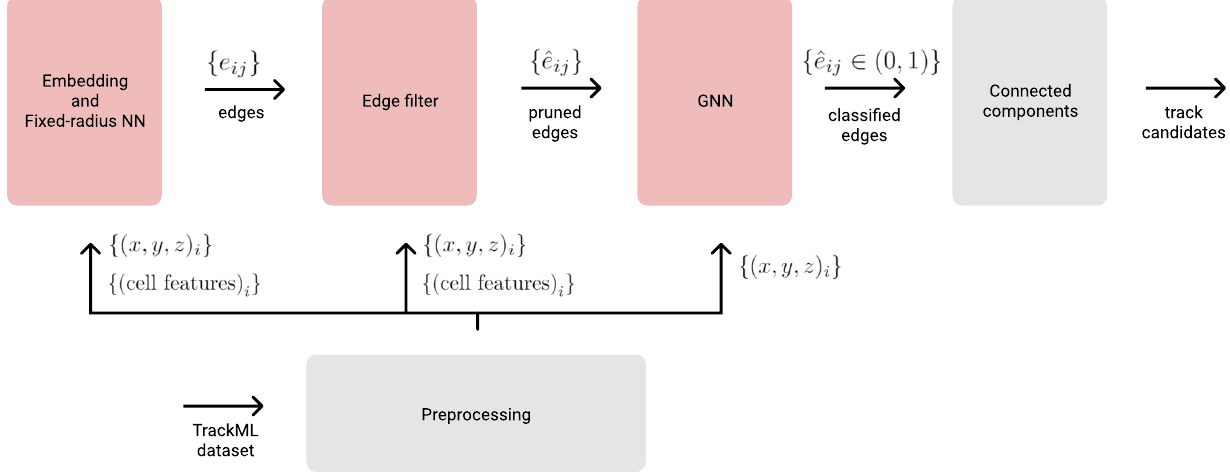
Fig. 4 Stages of the TrackML track formation inference pipeline. Light red boxes are trainable